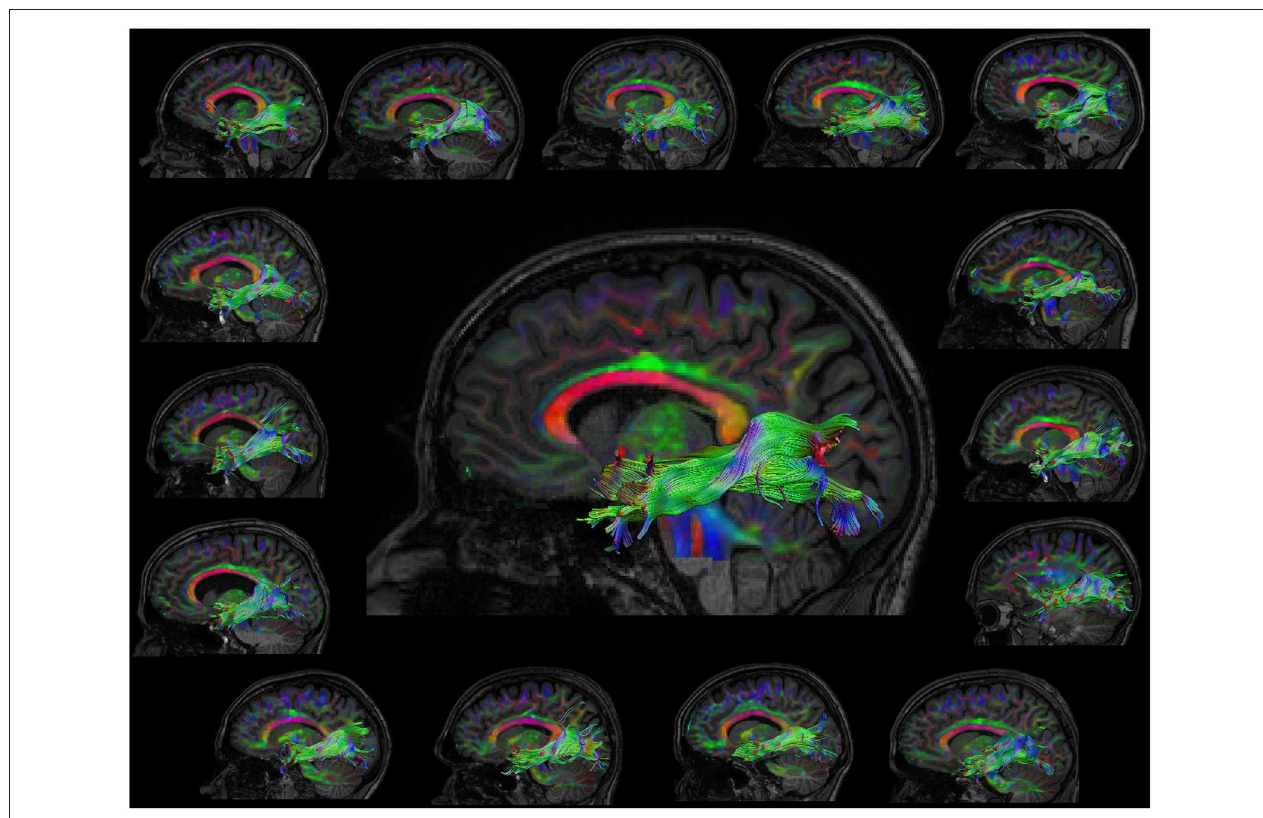
FIGURE 1 | Visualization of the left inferior longitudinal fasciculus (ILF) post learning for all subjects. The representative subject, which was initially used to define ROIs is shown in the middle.